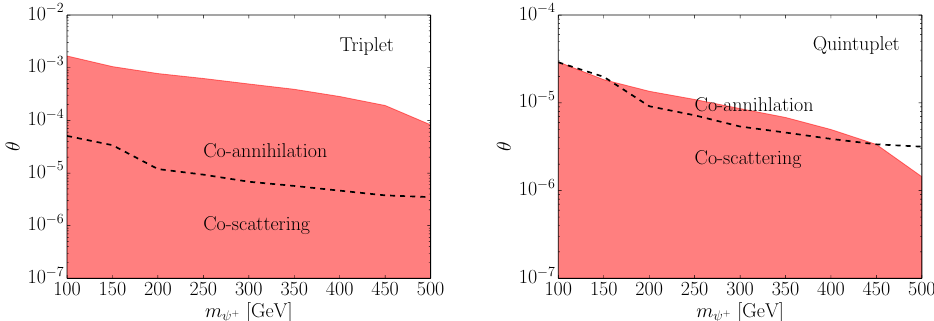
Figure 3 . The red shaded region shows exclusion from disappearing track search for the triplet (left) and quintuplet (right) interpreted in terms on the mixing angle (cid:18) . The dotted line corresponds to minimum values of (cid:18) required by self-consistent calculation of relic density via coannihilation. In either of these cases, the doubly charged fermion becomes stable on collider